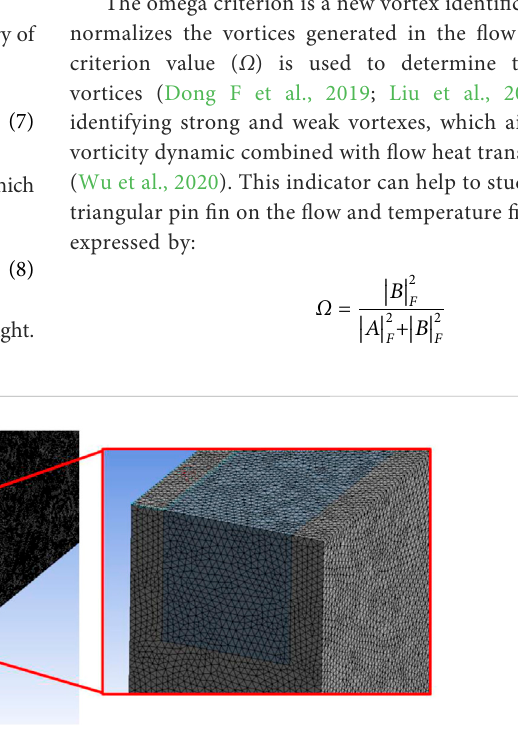
Figure 2. Too few grids will result in subpar accuracy, but too many grids will raise computation costs with no gain in accuracy. Therefore, the mesh size was set to 0.1 mm to meet the accuracy and computation time of the simulation, and the number of grids reached 3,764,518, as shown in Figure 3. The commercial software Fluent was chosen as the solver for the simulation.